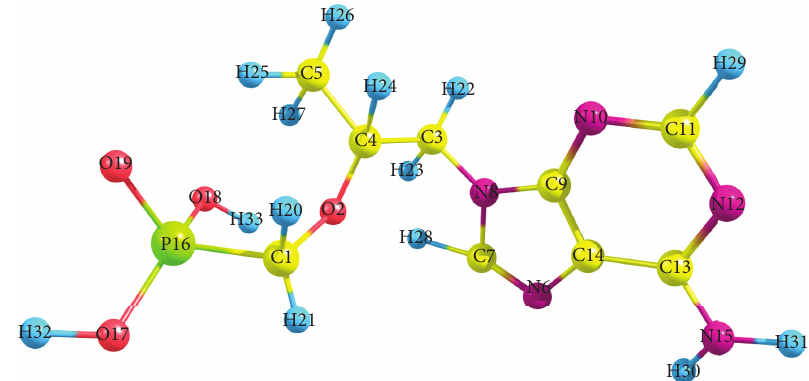
F 1: Atom numbering scheme of